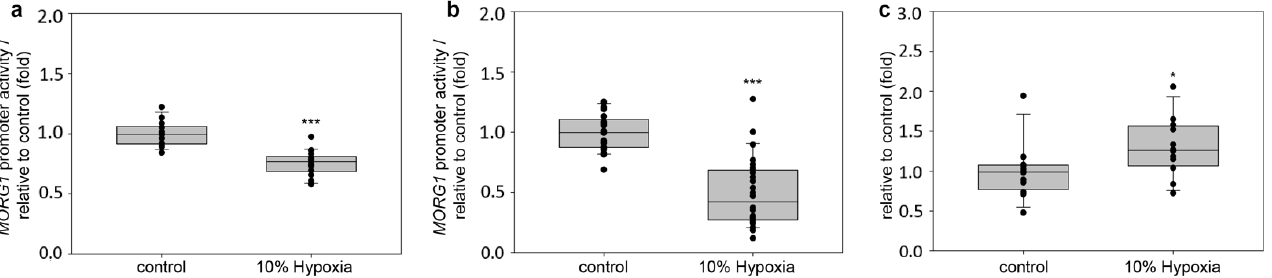
Figure 6. Influence of 10% hypoxia on the human MORG1 promoter reporter activity. Relative MORG1 promoter reporter activity in HEK 293 cells treated with 10% hypoxia (10% O 2 supply) for different time periods. The corresponding controls were grown at 21% oxygen supply (normoxia conditions). ( a ) Relative MORG1 promoter reporter activity at 6 h treatment. N = 14/18. *** p < 0.001 vs. control. ( b ) Relative MORG1 promoter reporter activity at 12 h treatment. N = 21/28. *** p < 0.001 vs. control. ( c ) Relative MORG1 promoter reporter activity at 24 h treatment. N = 12/12. * p < 0.05 vs. control.